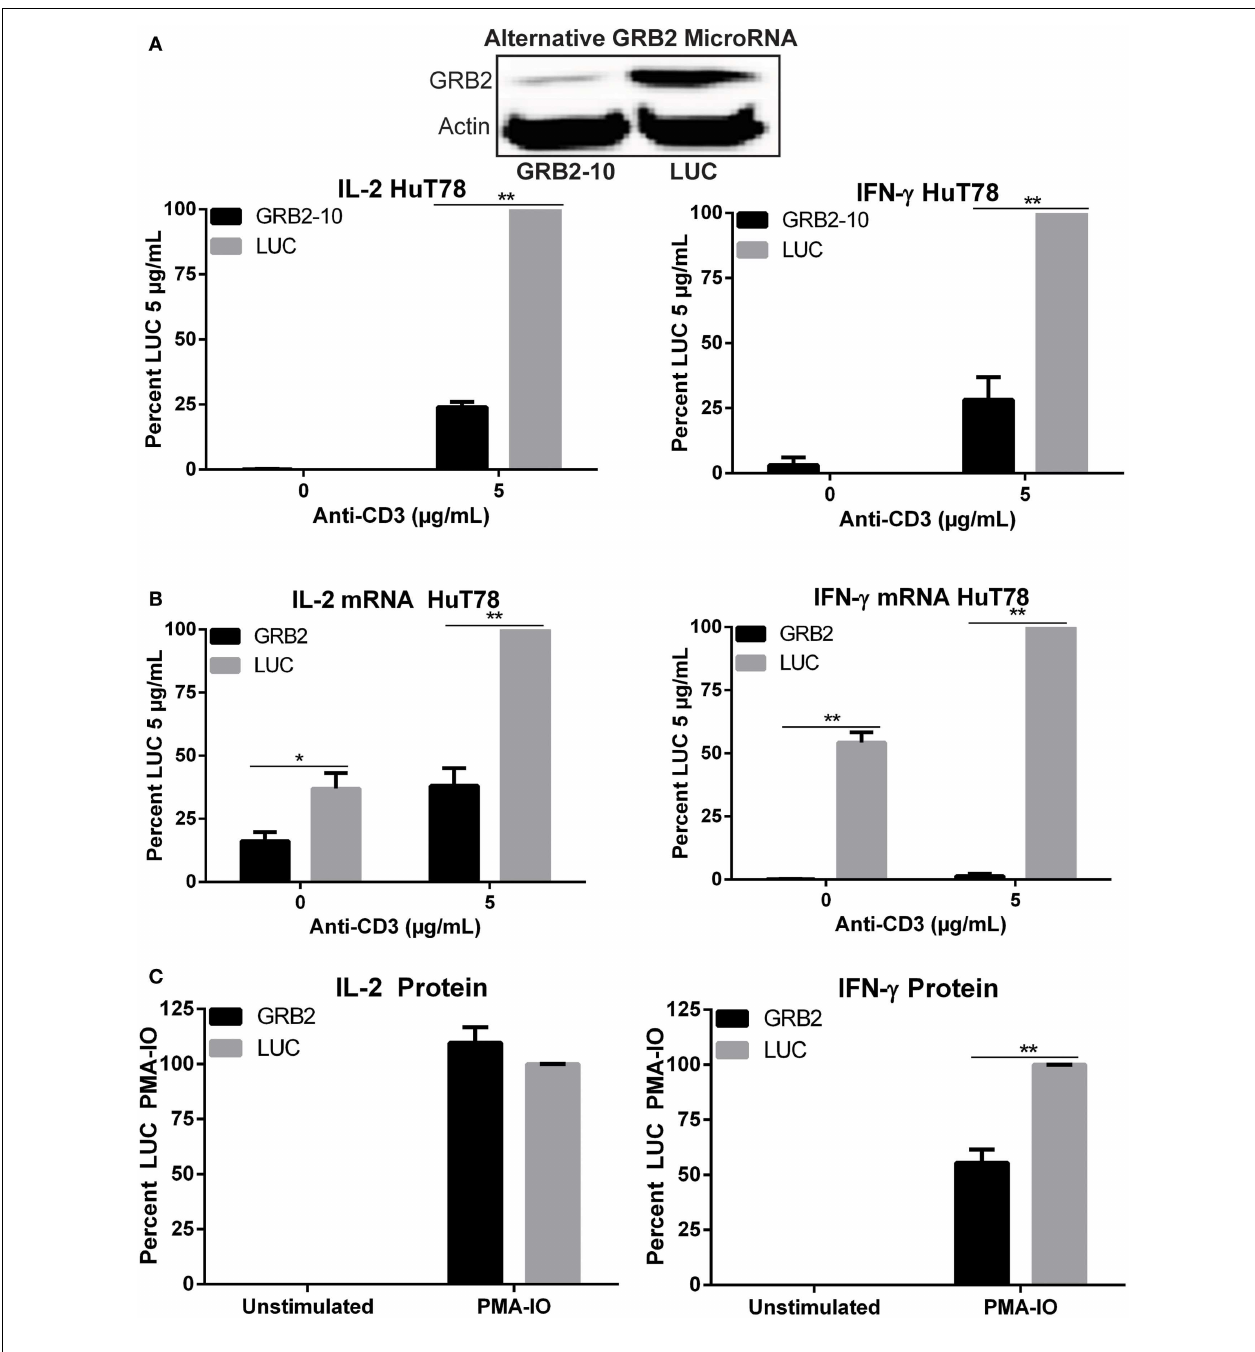
FIGURE 2 | ImpairedTCR-induced transcriptional activity and PMA-IO mediated cytokine release in GRB2 deficient HuT78T cells . (A) HuT78 T cells carrying an alternative GRB2 (GRB2-10) or LUC microRNA were stimulated with 5 µ g/mL plate-bound anti-CD3 for 24h and the supernatants were probed for IL-2 and IFN- γ via ELISA.The mean normalized value ± SEM from three independent experiments is shown.